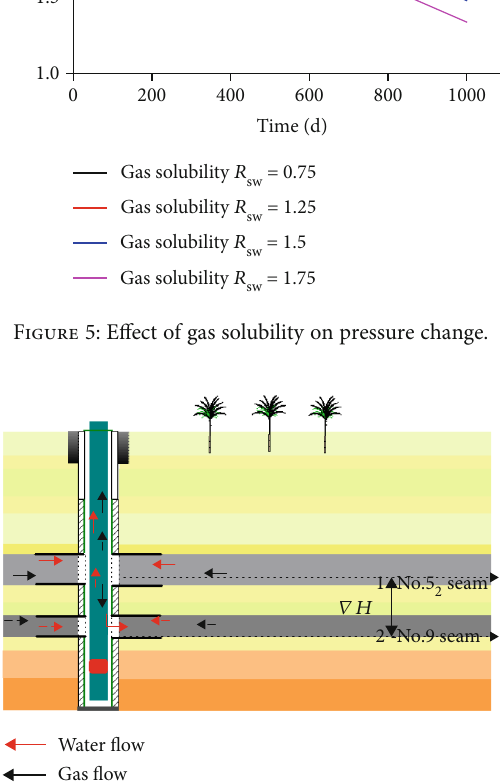
Figure 4: Variation of gas production rate with time.